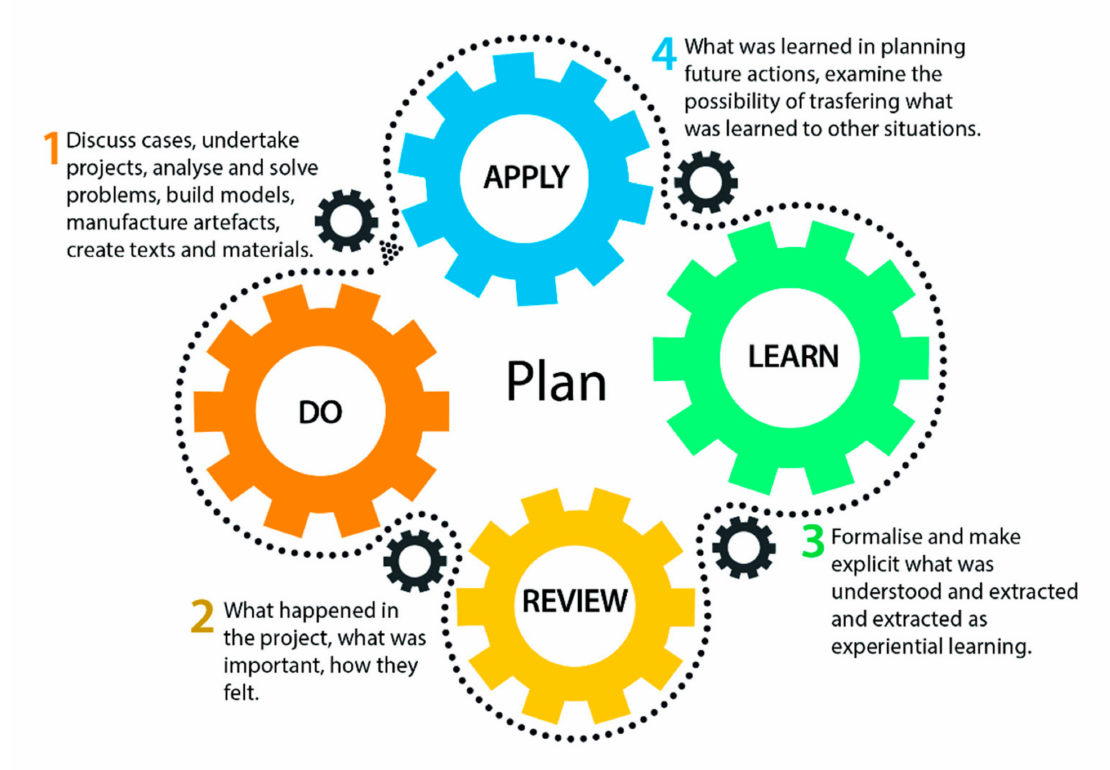
Figure 1. The active learning process (adapted from